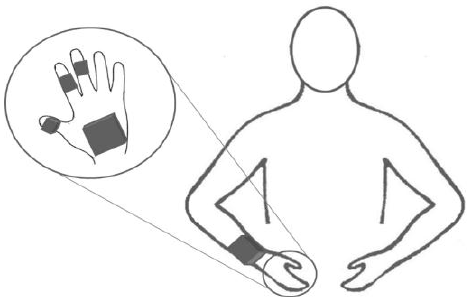
Figure 1. Placement of inertial sensors on the dominant hand and on the wrist. In the circle a focus on the placement of the SensHand is represented, while in the half-body figure the position of the wrist sensor is shown.